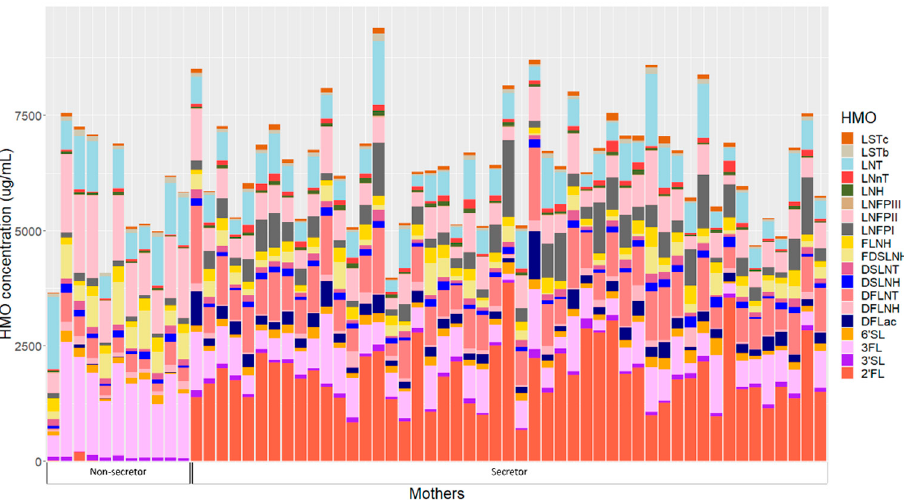
Figure 2. Human milk oligosaccharide concentrations in individual mothers based on secretor status. 2 ′ FL—2 ′ -fucosyllactose; 3 ′ SL—3 ′ -sialyllactose; 3FL—3-fucosyllactose; 6 ′ SL—6 ′ -sialyllactose; DFLac—difucosyllactose; DFLNH—difucosyllacto-N-hexaose; DFLNT—difucosyllacto-N-tetrose;